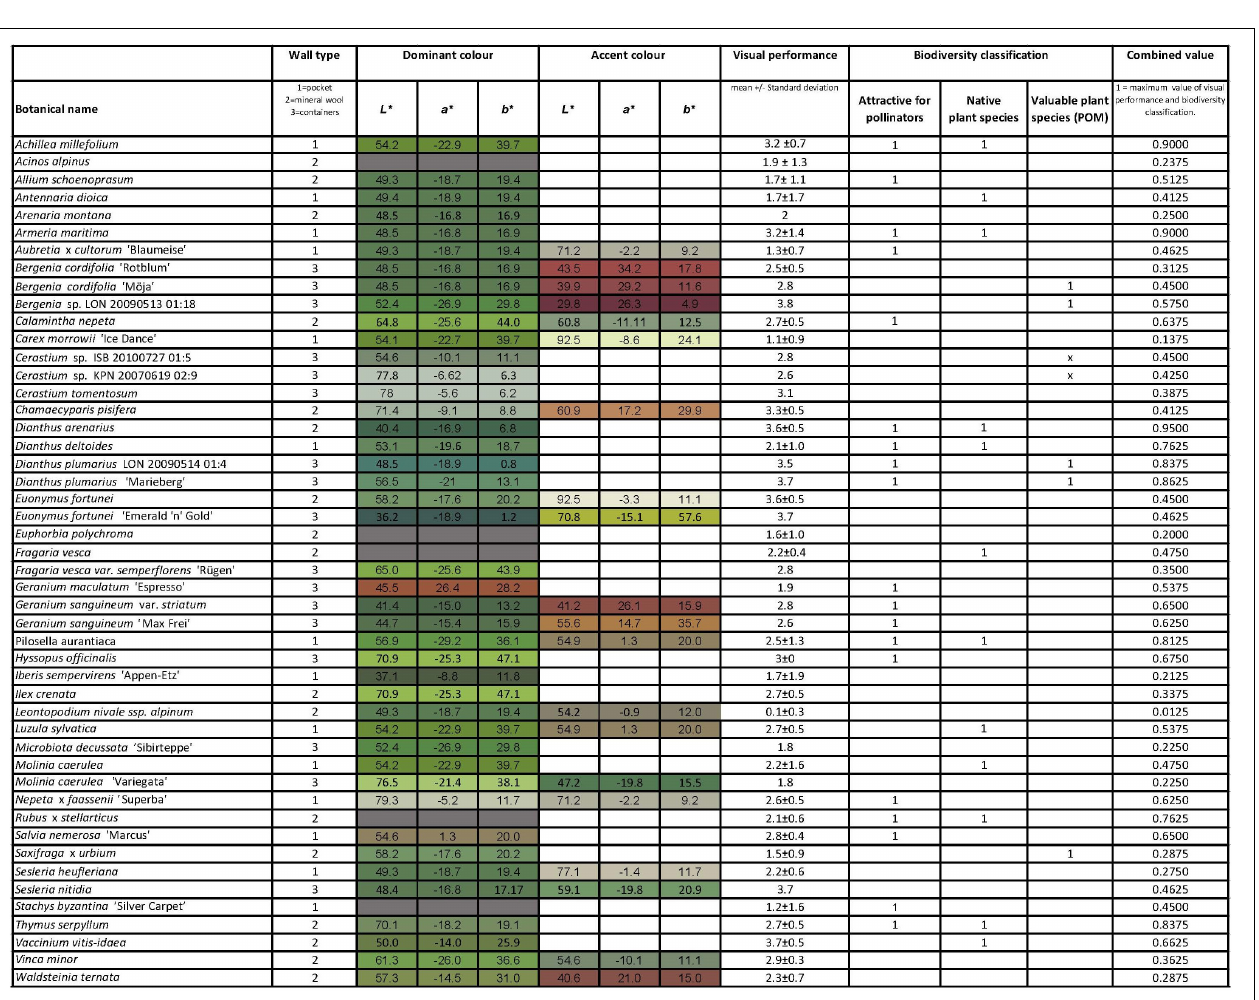
Frontiers in Ecology and Evolution |